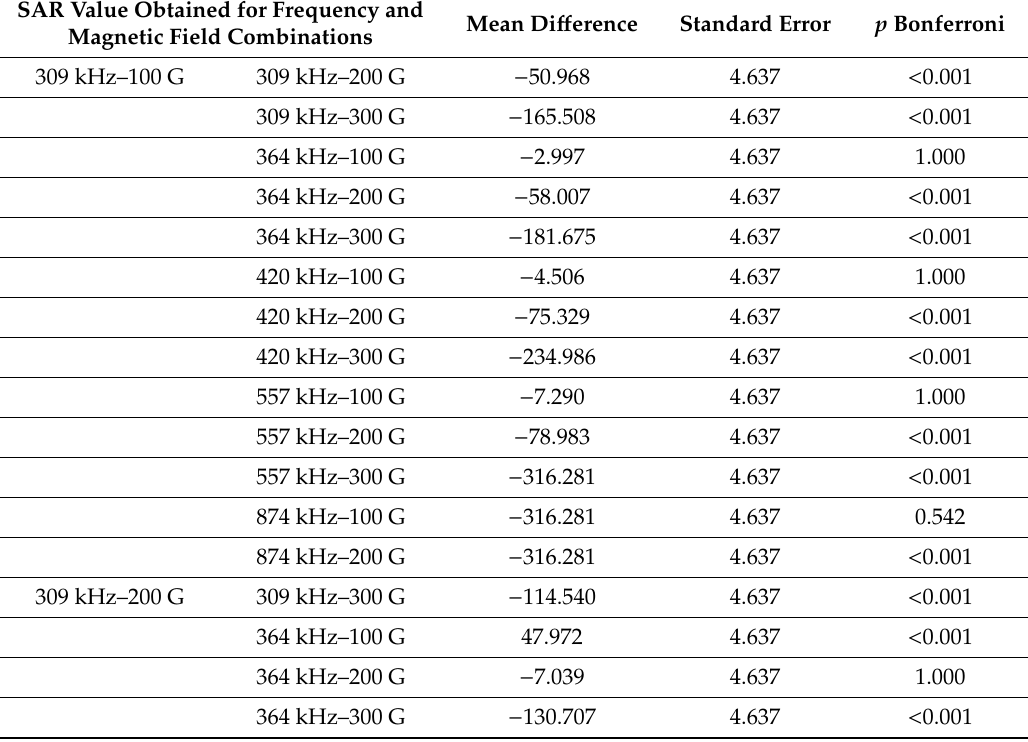
Table A1. Post Hoc analysis of SAR values obtained when submitted to the magnetic field of 100, 200 and 300 Gauss and frequency oscillation of 309, 364, 420, 557 and 874 kHz. SAR Value Obtained for Frequency